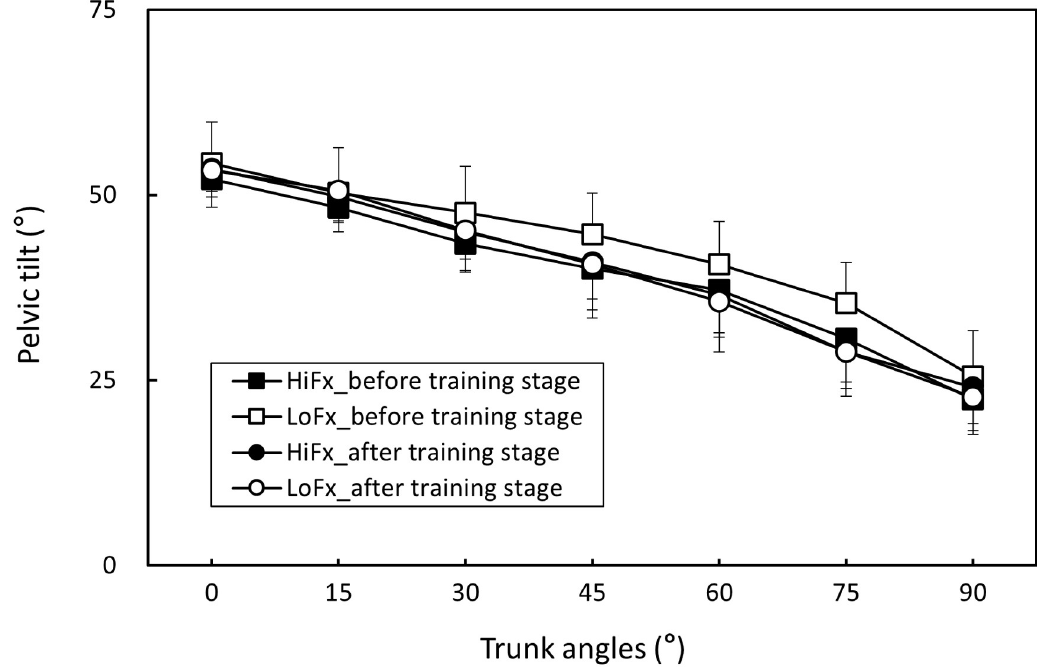
Fig 5. Changes in pelvic tilt (mean and standard deviation) in the two participant groups before and after flexibility training stage (HiFx: High flexibility; LoFx: Low flexibility).